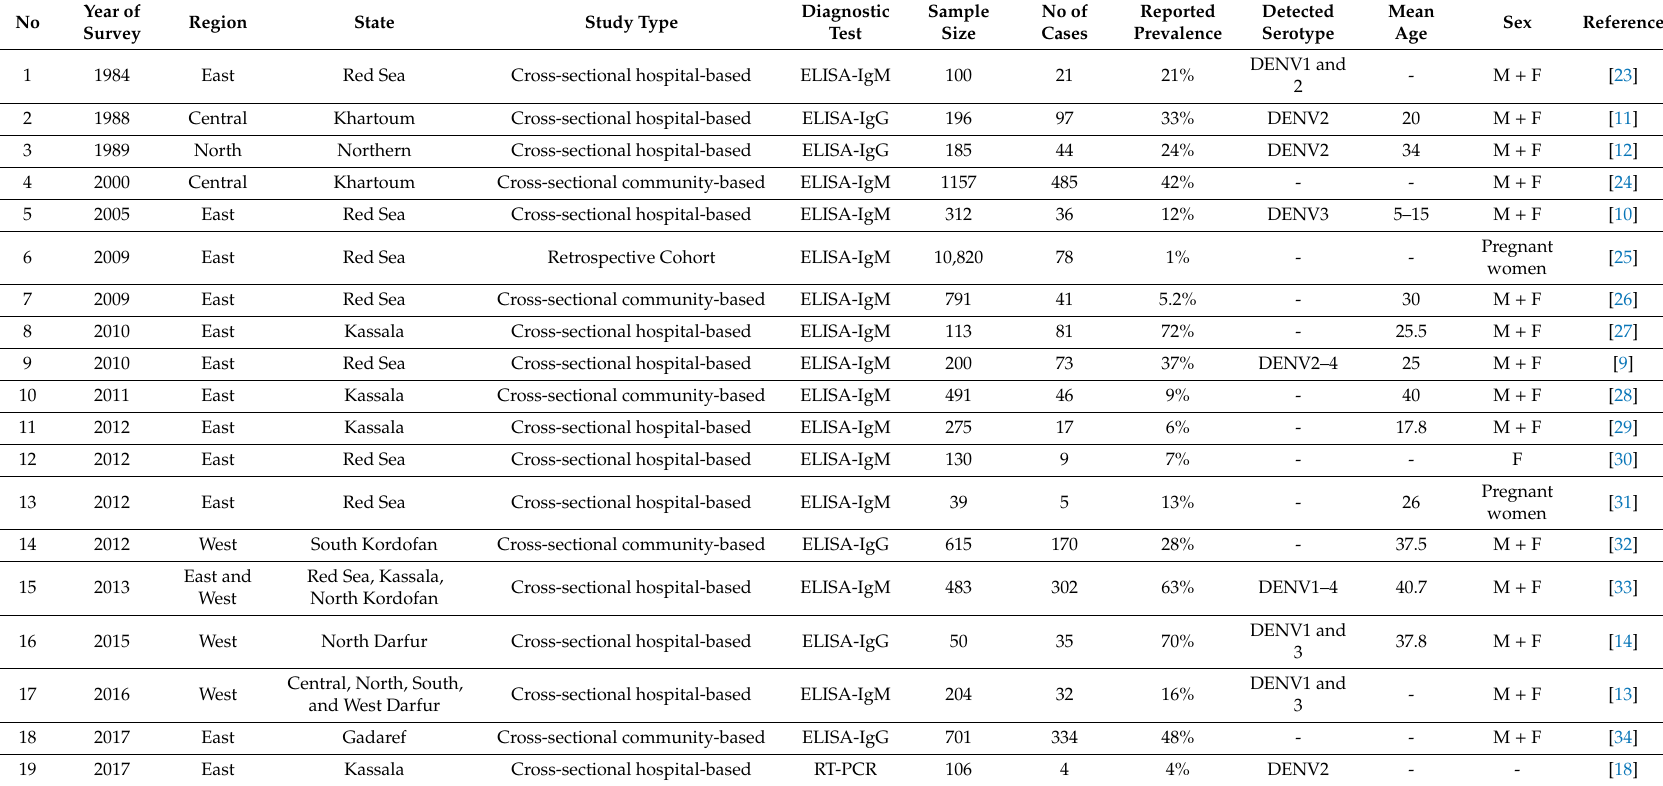
Table 1. List of studies that met the criteria to be included in the